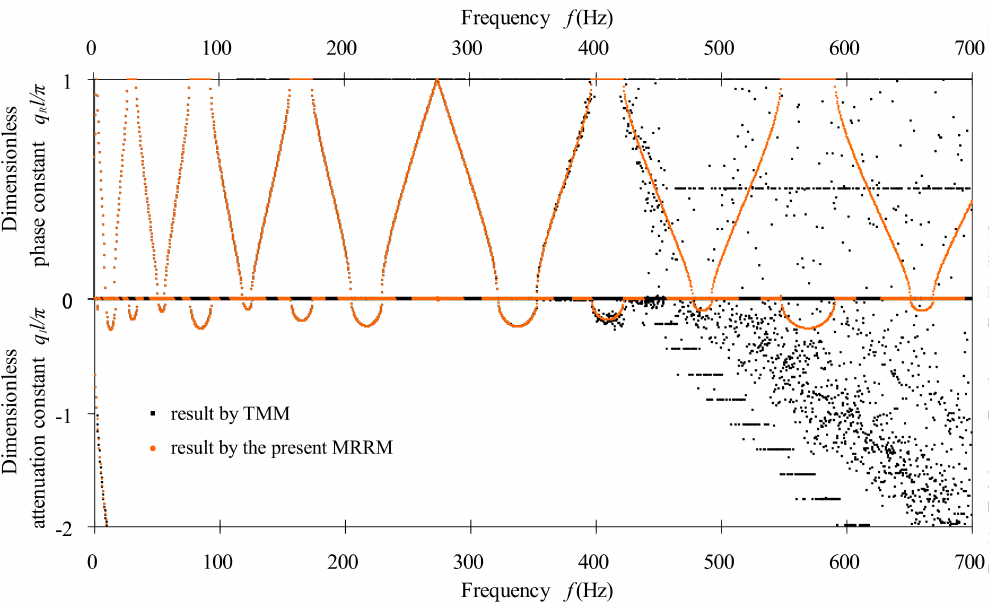
Figure 4. Comparison of the band structures obtained by the method of reverberation-ray matrix (MRRM) and transfer matrix method (TMM) for a bi-coupled periodic beam consisting of one Binary-II as the unit